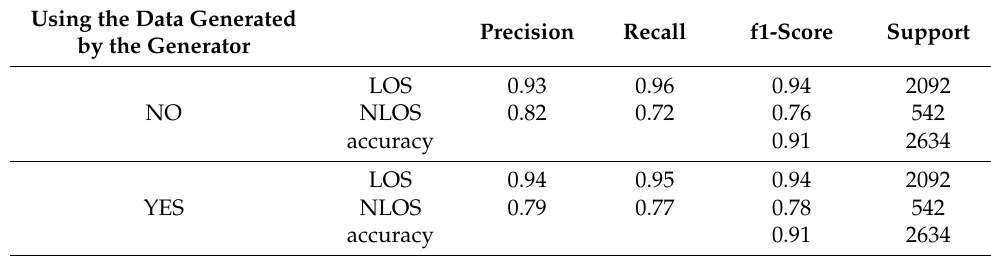
Table 5. Performance of our trained CNN